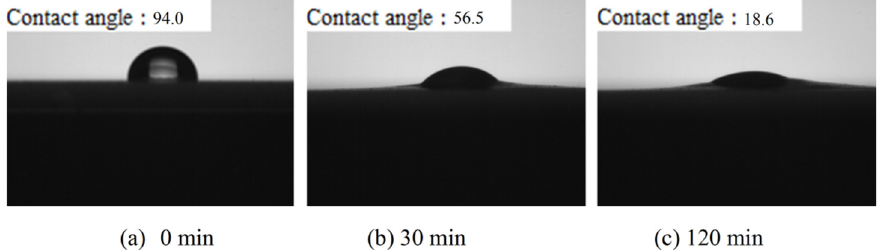
Figure 3. Surface water contact angle of oleic acid-cellulose sulfate films (CS + 25% OA